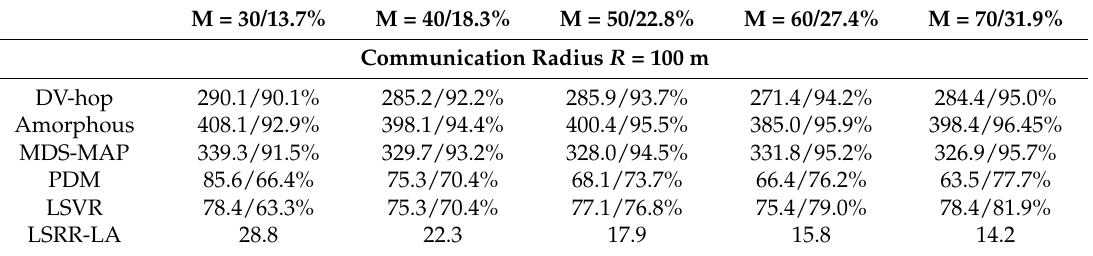
Table 4. Comparison of the ALE under different numbers of anchors in the regular distribution network.